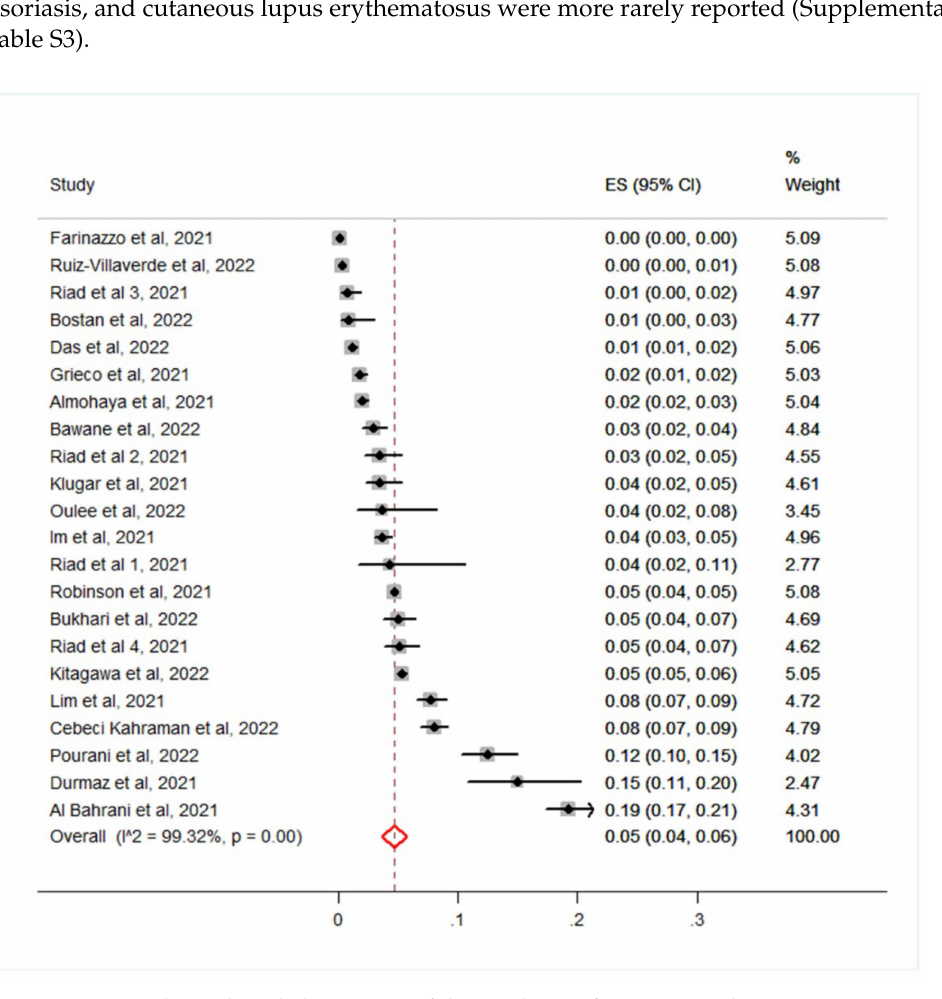
Figure 2. Forest plot and pooled estimates of the incidence of cutaneous adverse reaction to SARS- CoV-2 vaccines in 22 eligible